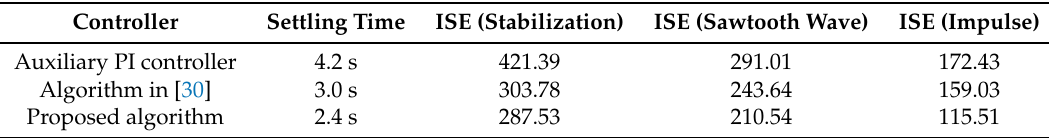
Figure 11. Input voltage applied to the air levitation system in the disturbance rejection experiment. From top to bottom: the proposed algorithm, the algorithm in [30], and the auxiliary PI controller. Table 1. Comparison of different